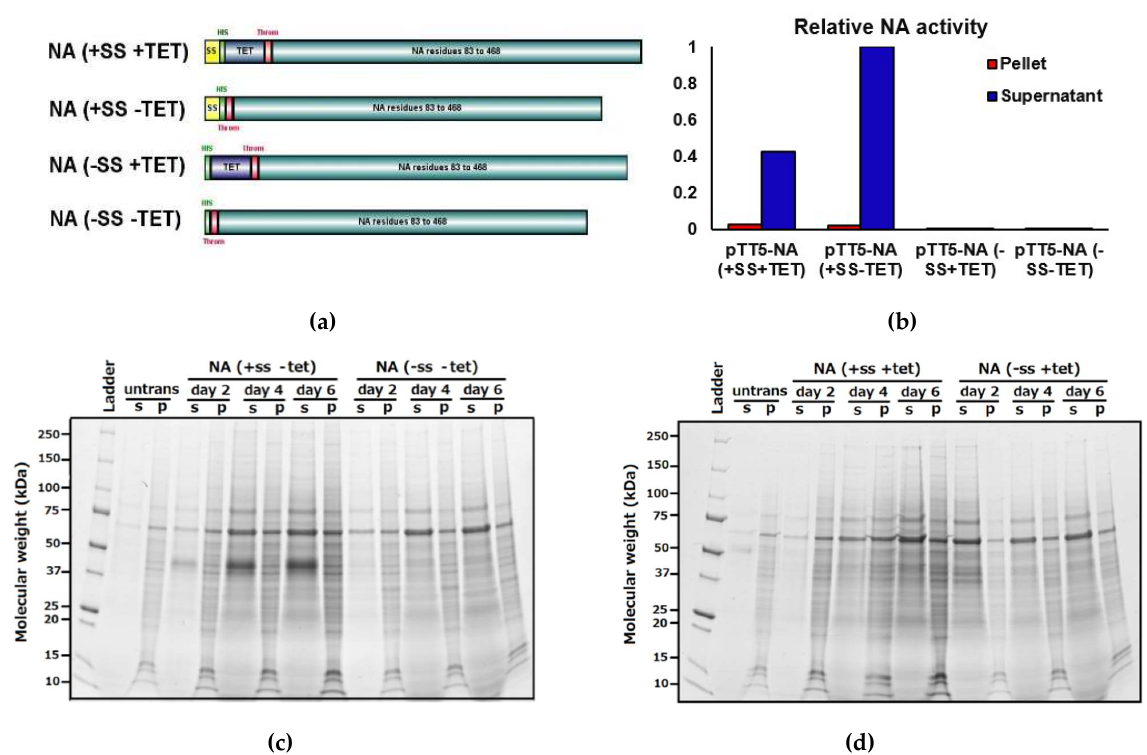
Figure 1. Optimisation of expression construct ( a ) H1N1 NA constructs used in this study. Each horizonal bar represents one of the four constructs used in this study. The secretion signal (SS) is shown in yellow, the His-tag is shown in green, the tetramerisation domain (TET) is shown in purple, the thrombin cleavage site is shown in red. This image was made with IBS software [65] . ( b ) Relative neuraminidase activity, plotted following normalization to the sample with the highest activity: pTT5-NA (+SS−TET). ( c – d ) SDS-Page gels (4–20%) from expression trials of NA (+SS +TET), (−SS +TET), (+SS −TET), (−SS −TET). The supernatant samples were concentrated 10× before loading. Untransfected cells (untrans) represent a negative control for NA expression. ( c ) shows expression of NA from constructs that did not contain a tetramerisation domain (−TET). ( d ) shows expression of NA from constructs which contained a tetramerisation domain (+TET). Both gels were stained with Coomassie Blue.